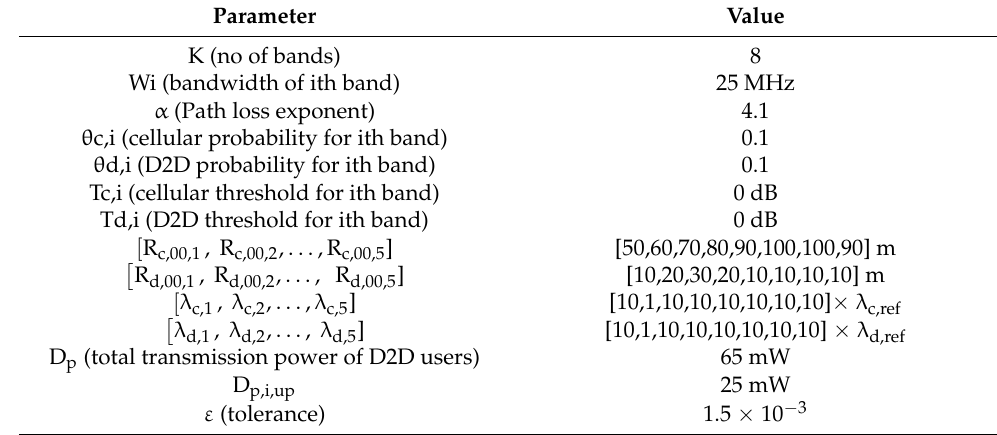
Table 3. Simulation parameters by using the modified derivative algorithm with different parame- ters.